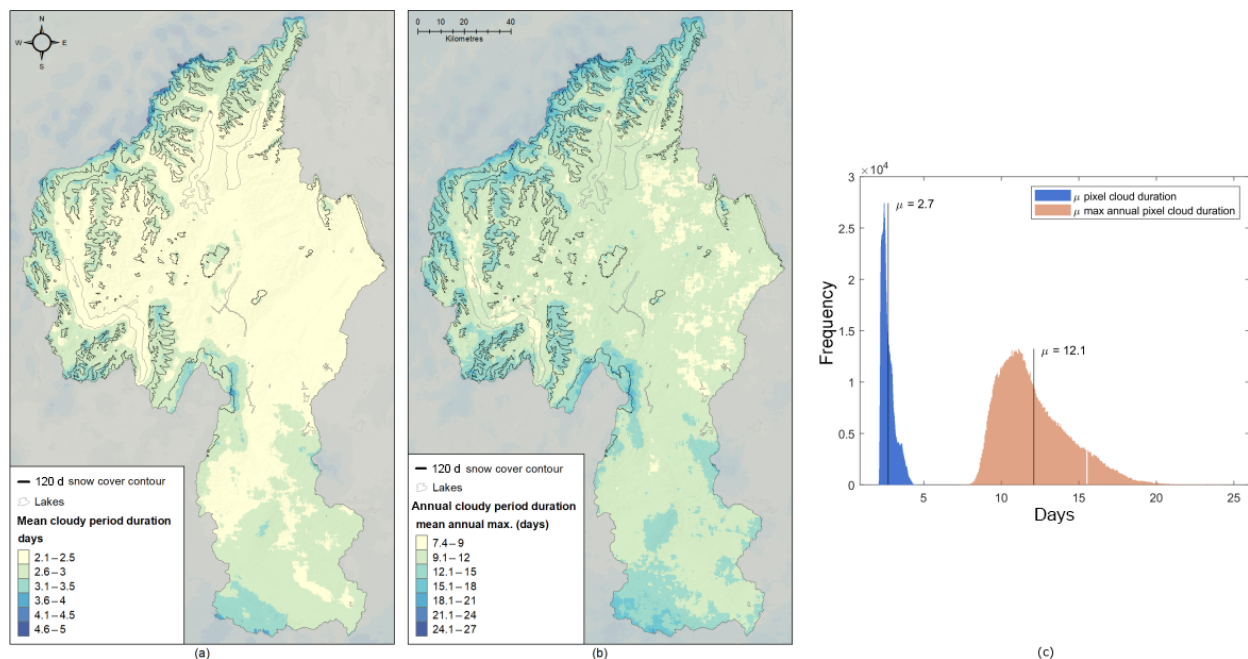
Figure 4. Maps of the mean duration of cloud occurrence (a) , mean of the maximum annual cloud occurrence duration (b) and histograms of both (c) . Lake outlines are sourced from the LINZ Topographic